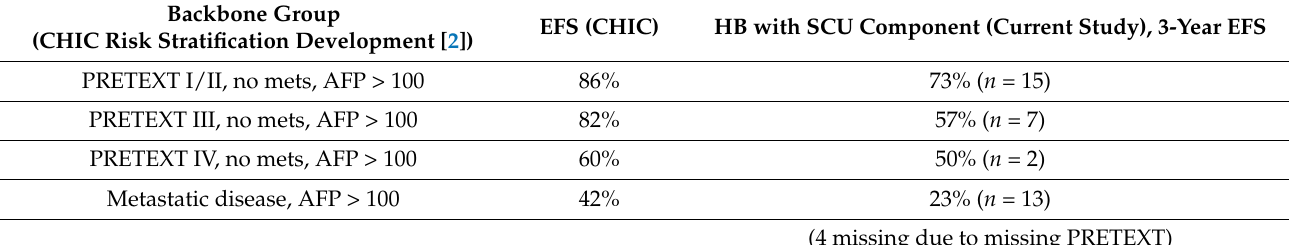
Table 4. Event-free survival comparison with original CHIC dataset, irrespective of histology. Backbone